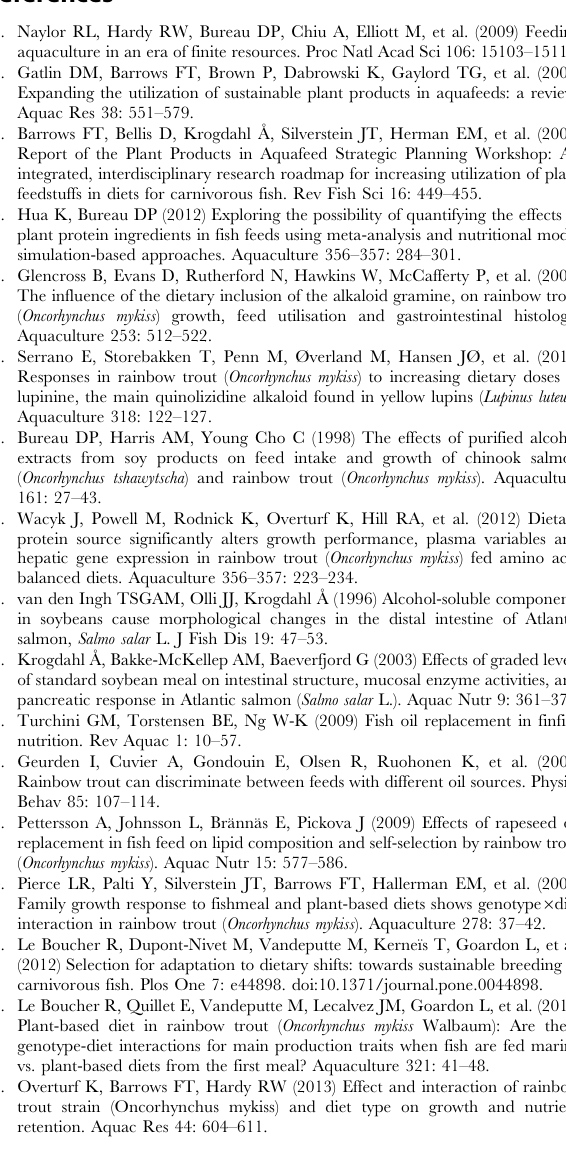
Figure S1 Illustration of the experimental design. Rainbow trout swim-up fry were fed for the first 3 weeks of exogenous feeding either with a plant-based diet (diet V) or with a diet containing fishmeal and fish oil as protein and fat source (diet M). This early feeding period is referred to as ‘nutritional history V or M’. After a 7-month common rearing period on diet M, both groups were challenged to feed the plant-based diet V during which voluntary FI, growth and nutrient utilisation were monitored (V-challenge). Figure S2 Growth (body weight, BW) of the fish during the pre-challenge phase (from first-feeding until the first day of V-challenge). The trout fry were fed either diet M or